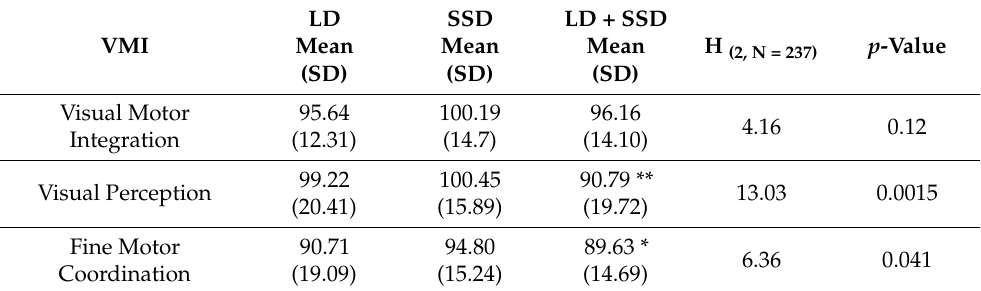
Table 4. Mean, SD, Kruskal Wallis H and p -value for Visual Motor Integration, Visual Perception and Fine Motor Coordination tasks by